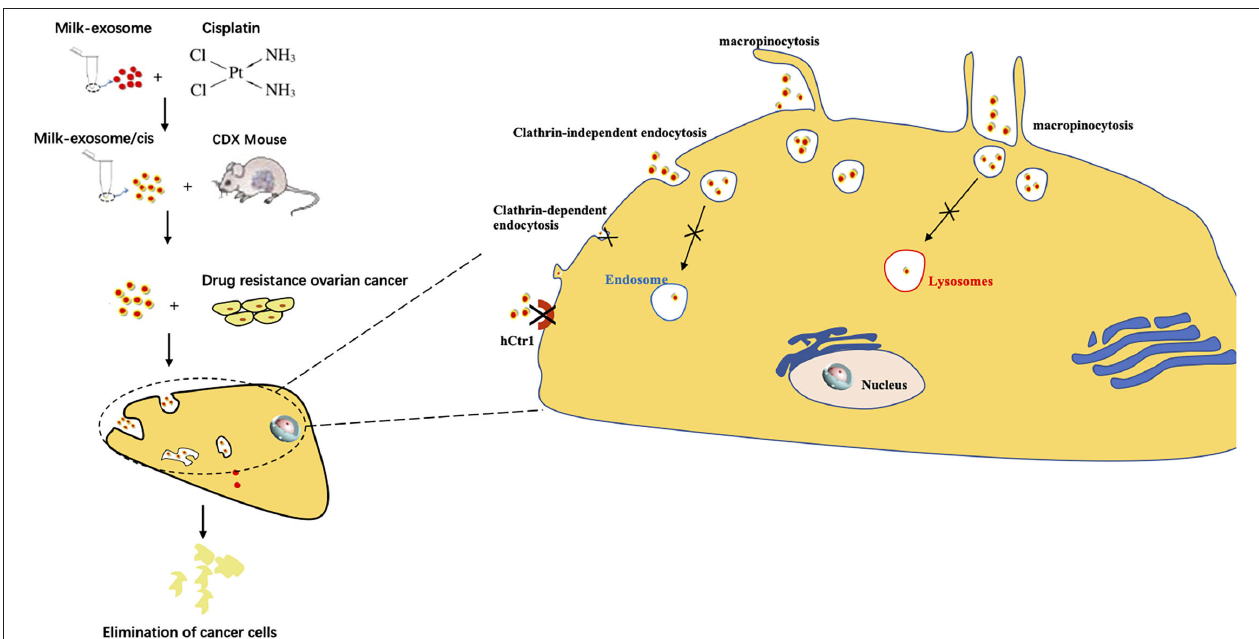
FIGURE 1 | Graphical abstract of this study. Exosome mediated cytosolic cisplatin delivery and enhanced anti-cancer effect in cisplatin-resistant ovarian cancer via avoiding endosome trapping.